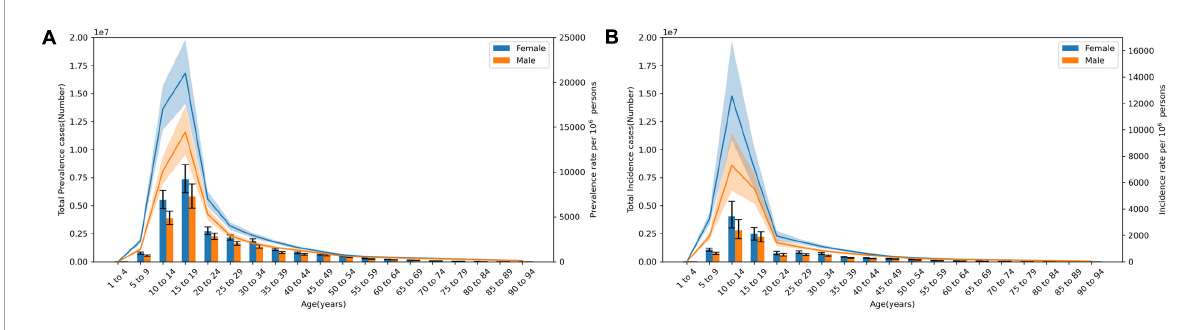
FIGURE2 Trends of acne vulgaris with age in China at 2019. (A) Prevalence rate and cases. (B) Incidence cases and rate.